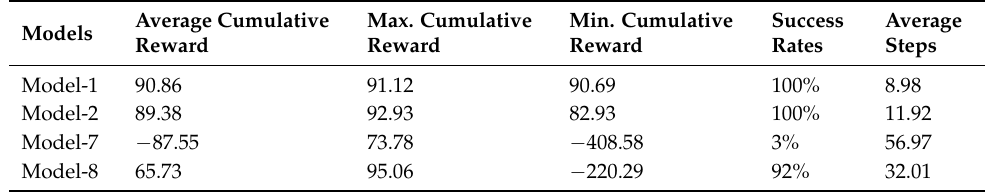
Table 5. DRL Models Test